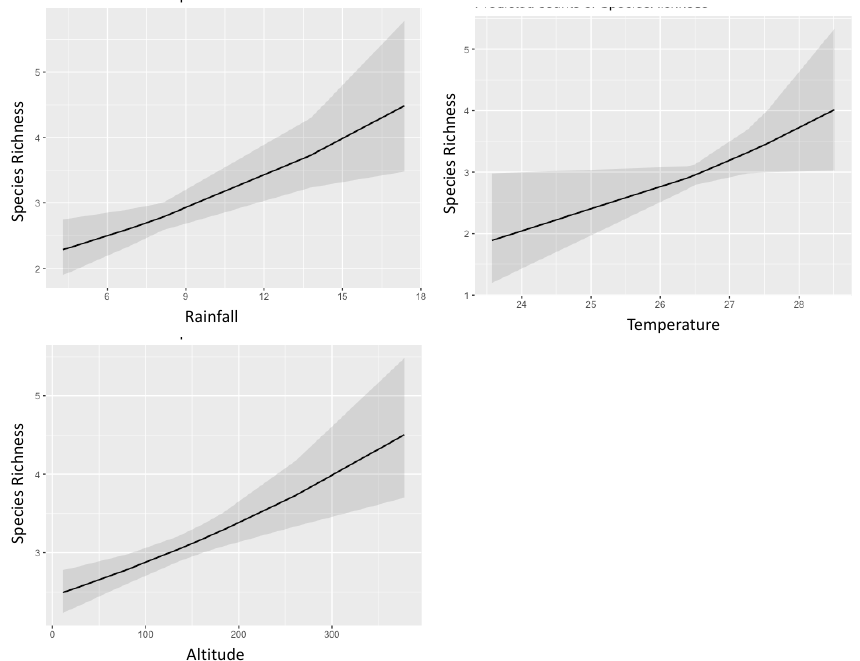
Figure 5. Predicted count of ambrosia beetle species richness on each significant factor, that is, rainfall, altitude, and temperature. Ambrosia beetle communities among the islands were significantly different, as con ‐ firmed by analysis of variance based on homogeneity of multivariate dispersion (sig. 0.001) and permutation test for homogeneity of multivariate dispersions (sig. 0.001). Based on the eigenvalues for PCoA axes, plots of the groups are visualized as shown in Figure 6. Sulawesi island differs from both Java, and Sumbawa islands in Figure 6A (based on PCoA1 and PCoA2). The same tendency is also described in Figure 6B (PCoA1 and PCoA3).